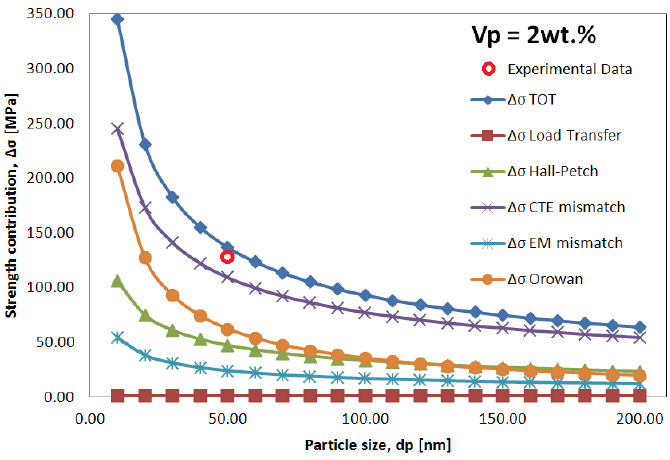
O reinforced Al matrix 2 3